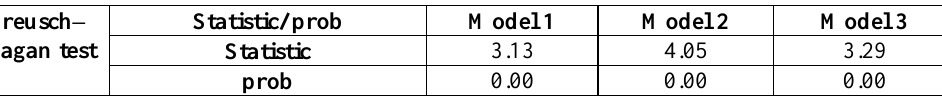
Table 3. Homogeneity of Variance test for the